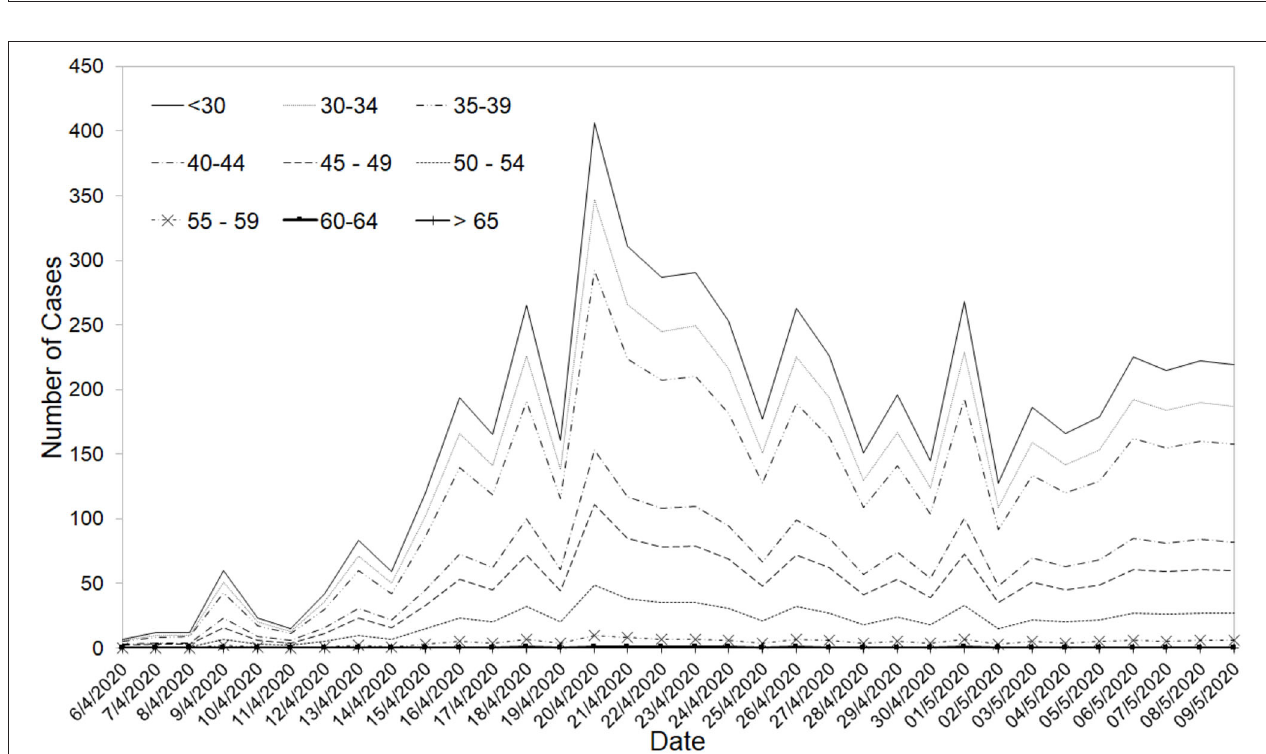
FIGURE 4 | Multivariate sensitivity analysis for: (A) Best Case ICU beds requirements, and (B) Base Case ICU beds requirements [Assumptions: SH with a national demand coverage of 4–8% and median ICU LOS of 7–18 days].